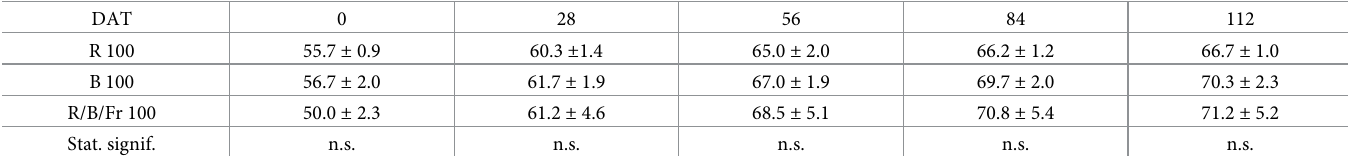
Table 8. Plant height (cm) at various days after treatment (DAT) in Taxus baccata exposed to different light quality (R, red; B, blue; Fr, far red) at 100 μ M m -2 s -1 . Data are means ± SE (n = 6).